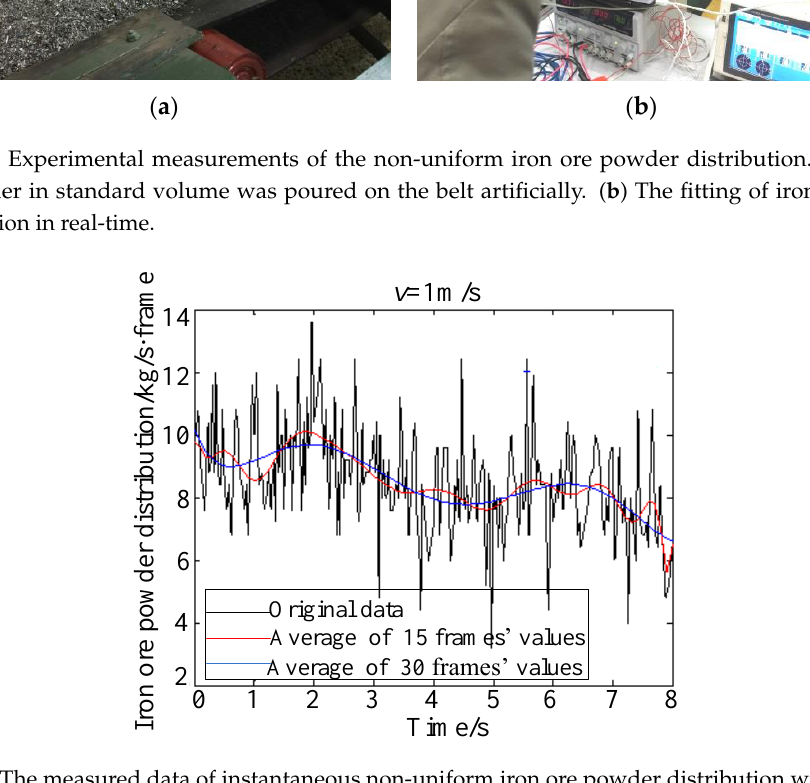
Figure 9. The measured data of instantaneous non-uniform iron ore powder distribution with a flow rate of 8.911 kg/s (3L/s) at a stable speed of 1.0 m/s.